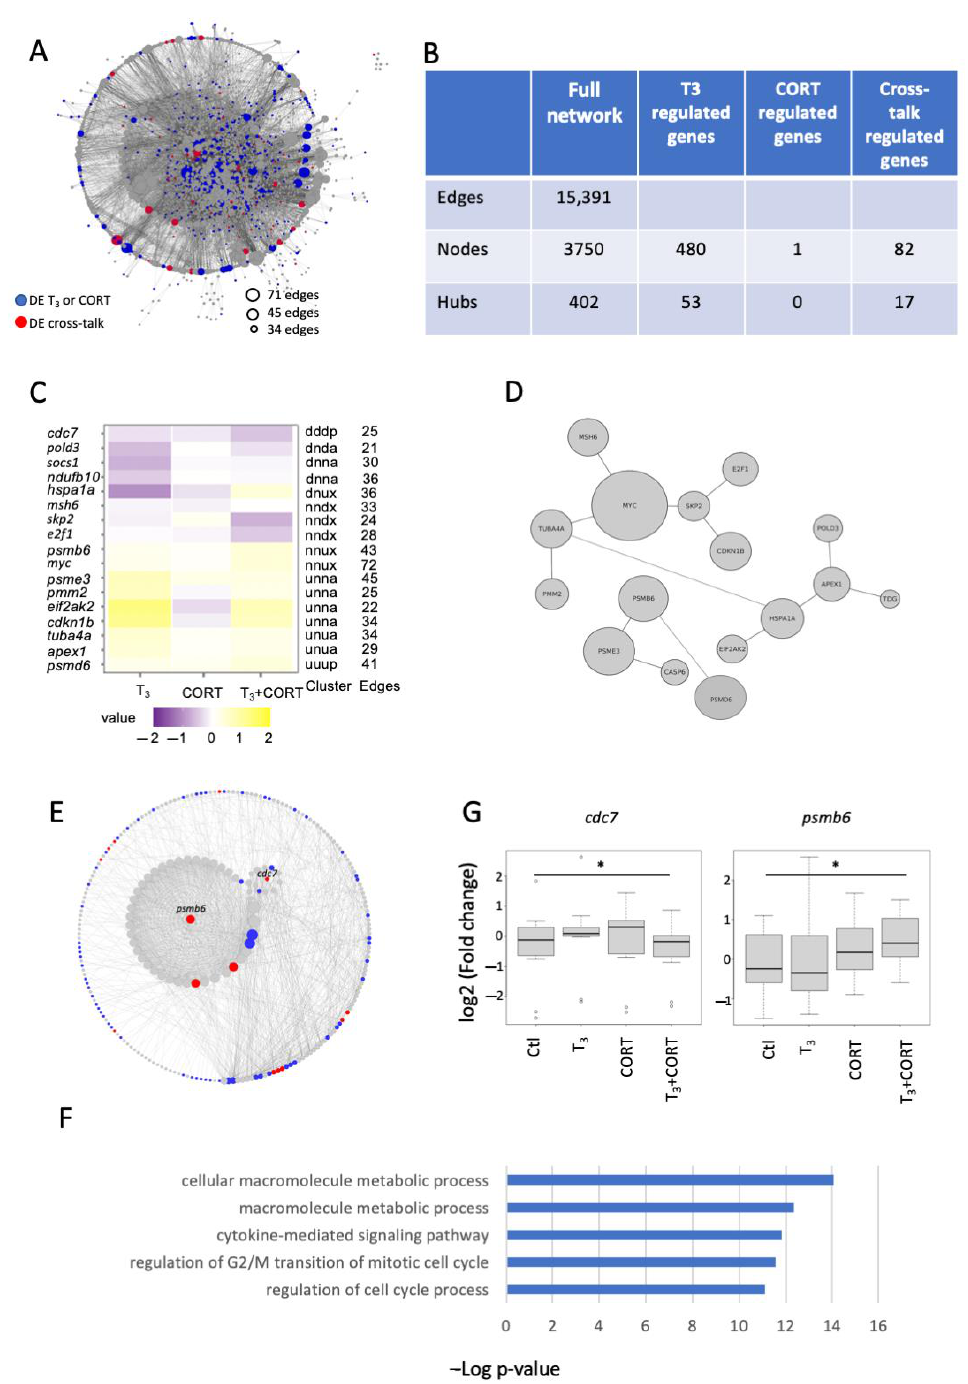
Figure 4. Network analysis of gene expression changes: ( A ) network for T 3 and CORT DE genes (blue), crosstalk-regulated genes (red), and non-DE genes (grey). ( B ) Characteristics of the network. ( C ) Heatmap showing the expression pattern and the connections of the hubs. ( D ) Chains. ( E ) Gene ontology analysis of the crosstalk-regulated hubs compared to the network. ( F ) psmb6 - cdc7 subnetwork. ( G ) Validation of the crosstalk regulation of psmb6 and cdc7 by RT-qPCR. * p < 0.05 and